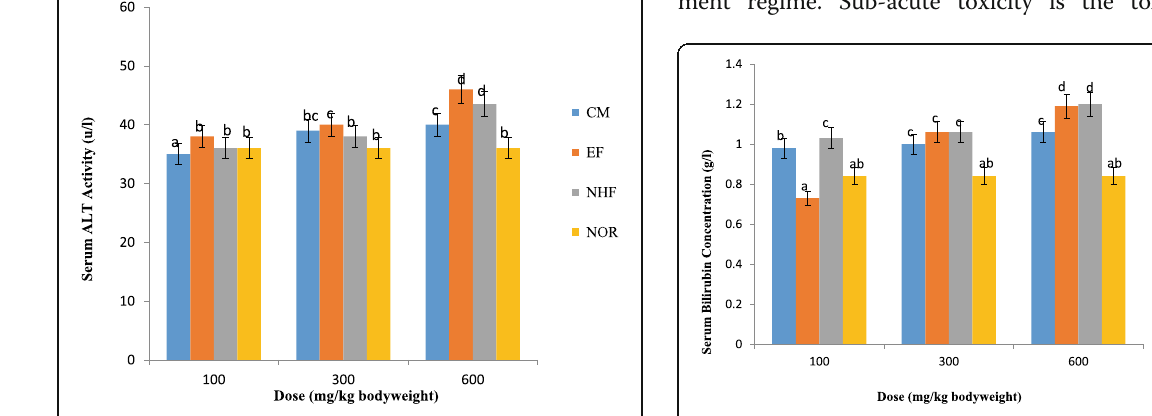
Fig. 2 Effect of crude extract and fractions of Gymnema sylvestre on serum alanine aminotransferase of rats. Mean with different superscripts differ significantly (p < 0.05). Key: NOR: normal control, CM: crude methanol extract, EF: ethyl acetate fraction, NHF: